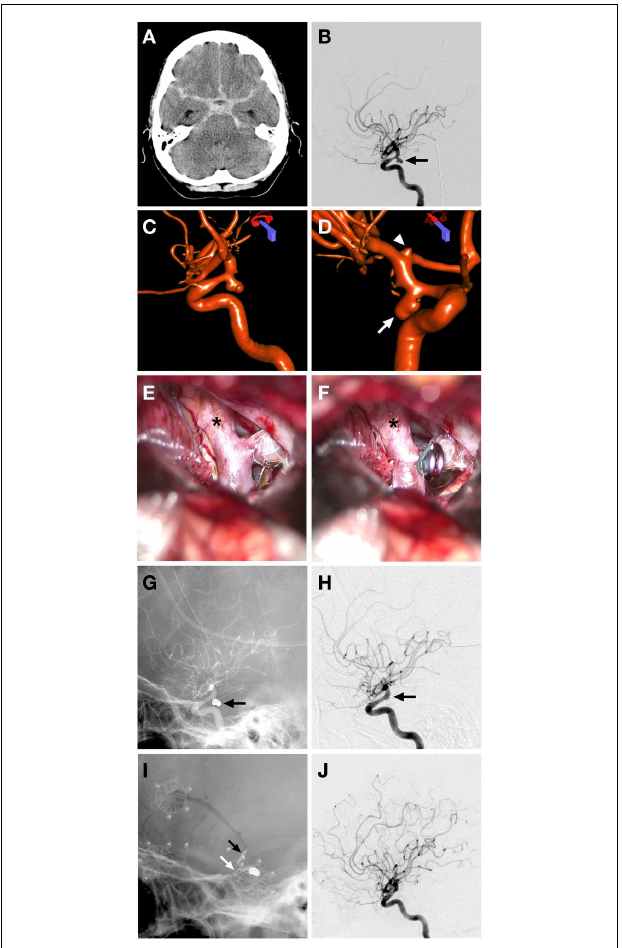
FIGURE 1 | Case 1 . (A) CT non-contrast demonstrating diffuse subarachnoid hemorrhage in the basal cisterns and prominent temporal horns; (B) lateral projection cerebral angiogram demonstrating a PComm aneurysm (arrow); (C) 3D angiographic reconstruction of right ICA showing the 5mm Pcomm aneurysm; (D) another view of the 3D angiogram demonstrating the ruptured Pcomm aneurysm (arrow) and the 3mm unruptured right ICA terminus aneurysm (arrowhead); (E,F) intraoperative microscope views showing exposure of the right Pcomm (asterisk), with visualization of coils in the aneurysm dome and continued filling of the aneurysm base (E) and obliteration of aneurysm residual after placement of aneurysm clip; (G) unsubtracted lateral cerebral angiogram demonstrating the coil mass obliterating the aneurysm dome (arrow); (H) subtracted lateral cerebral angiogram showing filling of residual aneurysm base (arrow); (I) magnified unsubtracted angiographic view post coiling and clipping with a microsurgical clip across the residual Pcomm aneurysm (white arrow) and ICA terminus aneurysm (black arrow); (J) final lateral subtracted angiogram showing complete obliteration of previously filling Pcomm aneurysm.